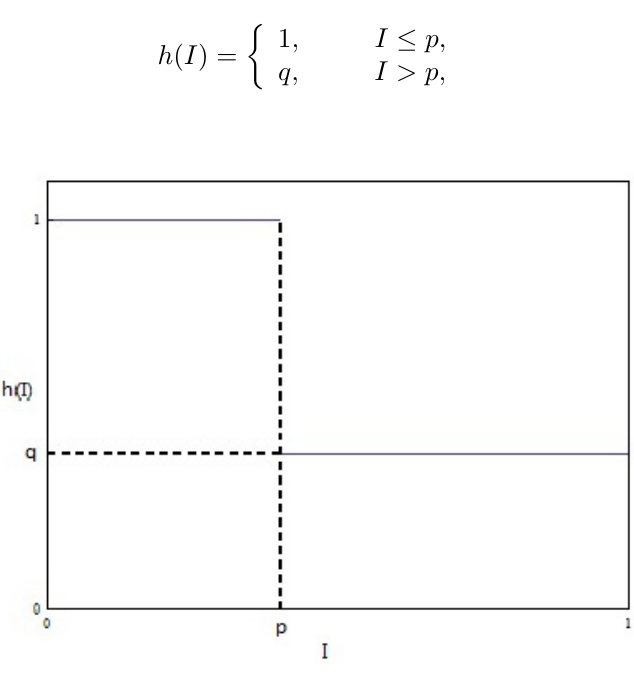
Fig. 1. The graph of h ( I )